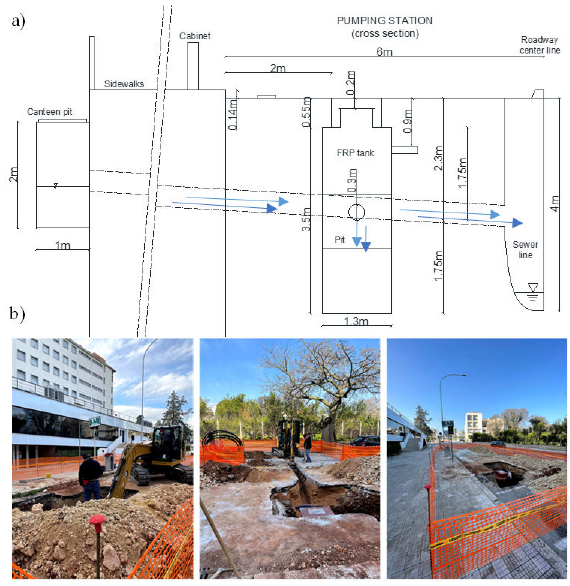
Figure 2. ( a ) Scheme of the pumping station; ( b ) photos of the excavation and pumping station con-